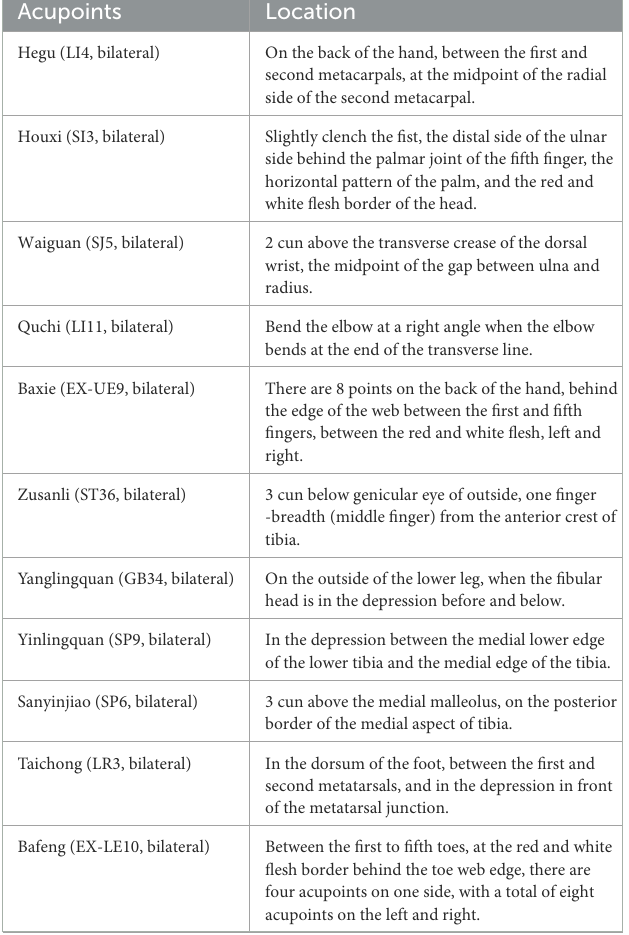
TABLE 3 Location of acupoints for treating PN caused by UTD1. Acupoints